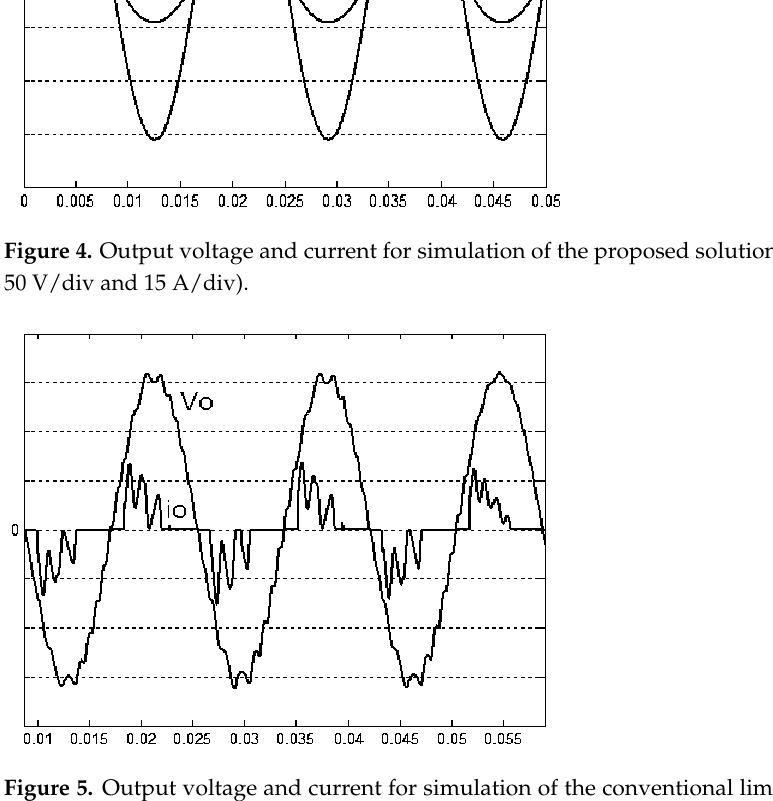
Figure 5. Output voltage and current for simulation of the conventional limited ‐ time convergent VSC under rectifier ‐ type load (vertical: 50 V/div and 25 A/div).